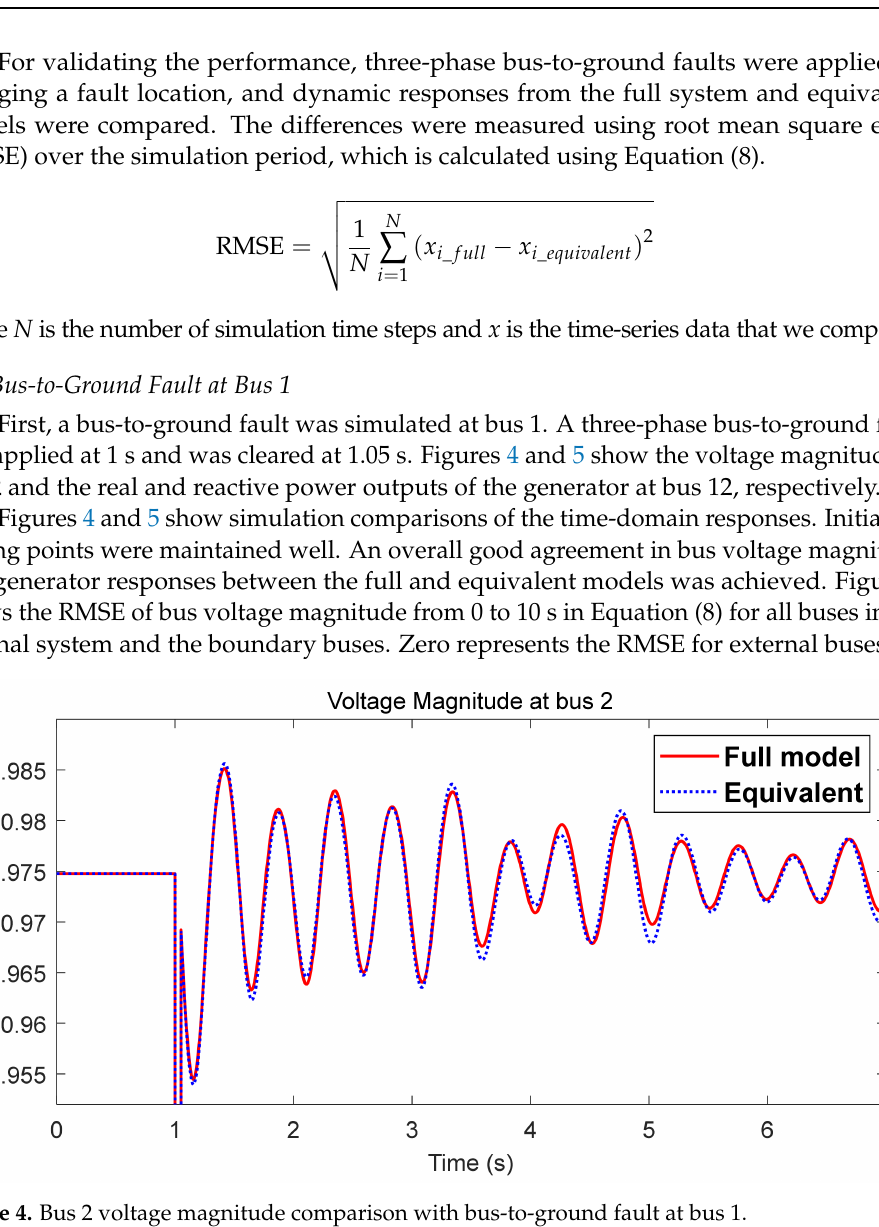
Figure 4. Bus 2 voltage magnitude comparison with bus-to-ground fault at bus